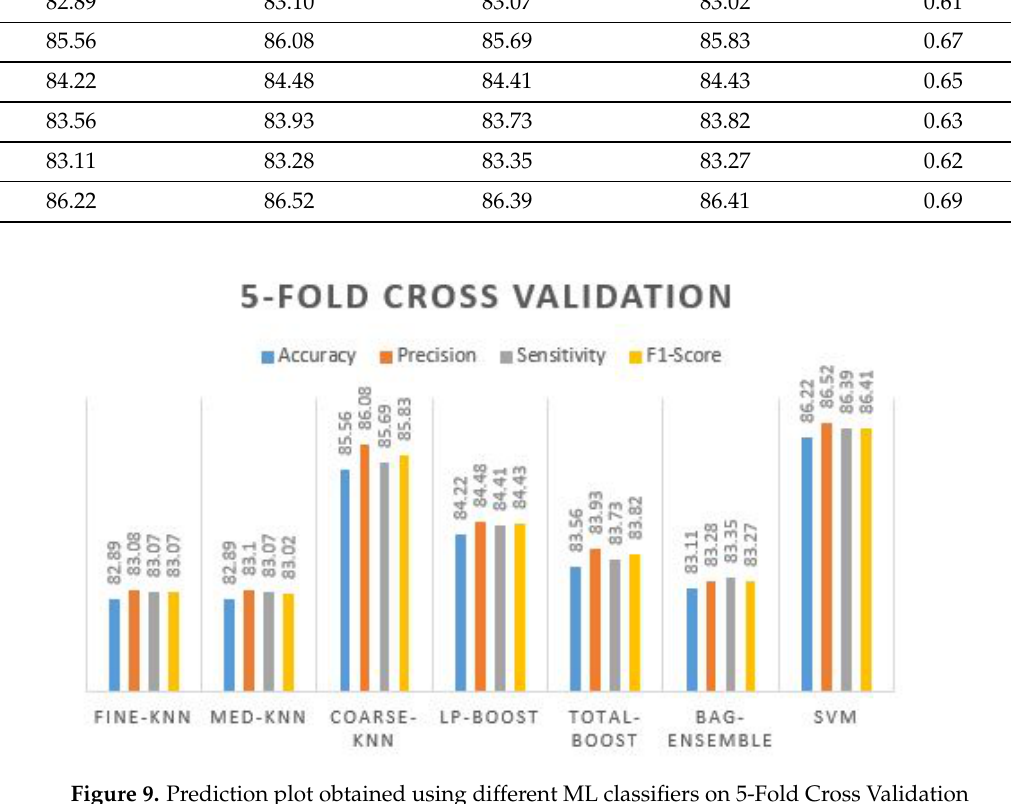
Figure 9. Prediction plot obtained using different ML classifiers on 5-Fold Cross